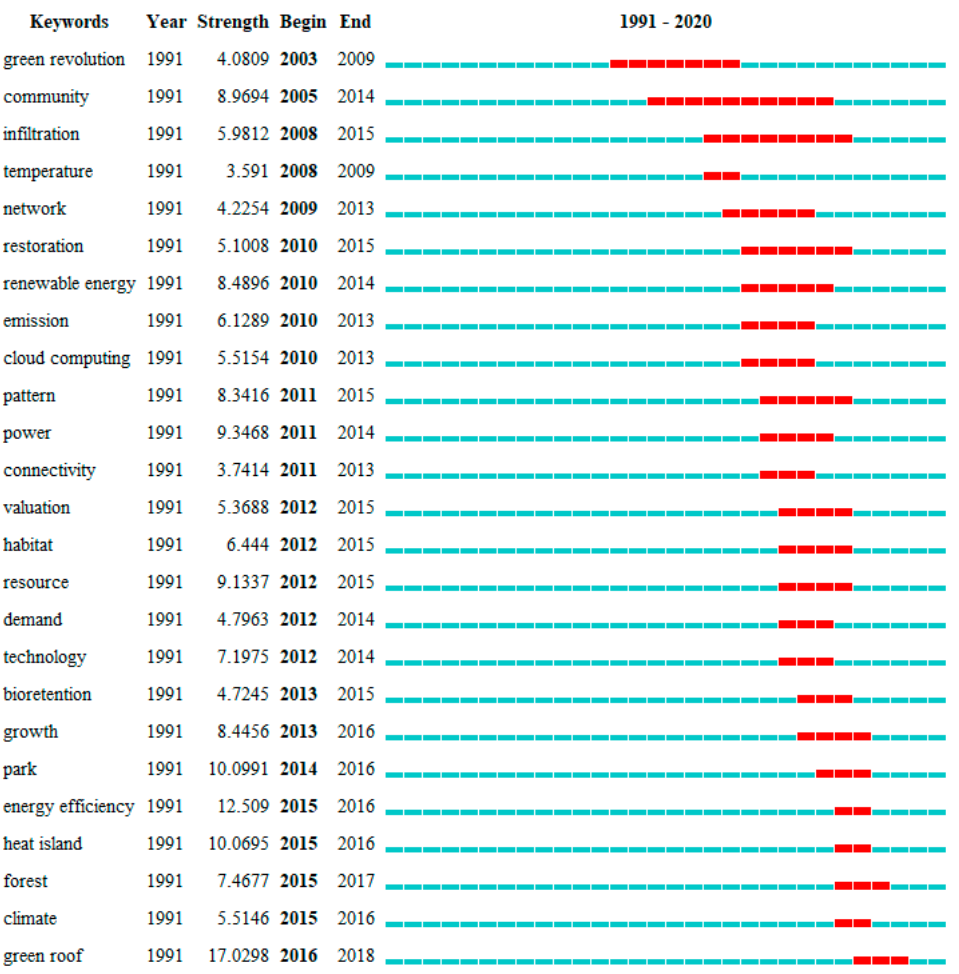
Figure 6. Time sequence of keywords.